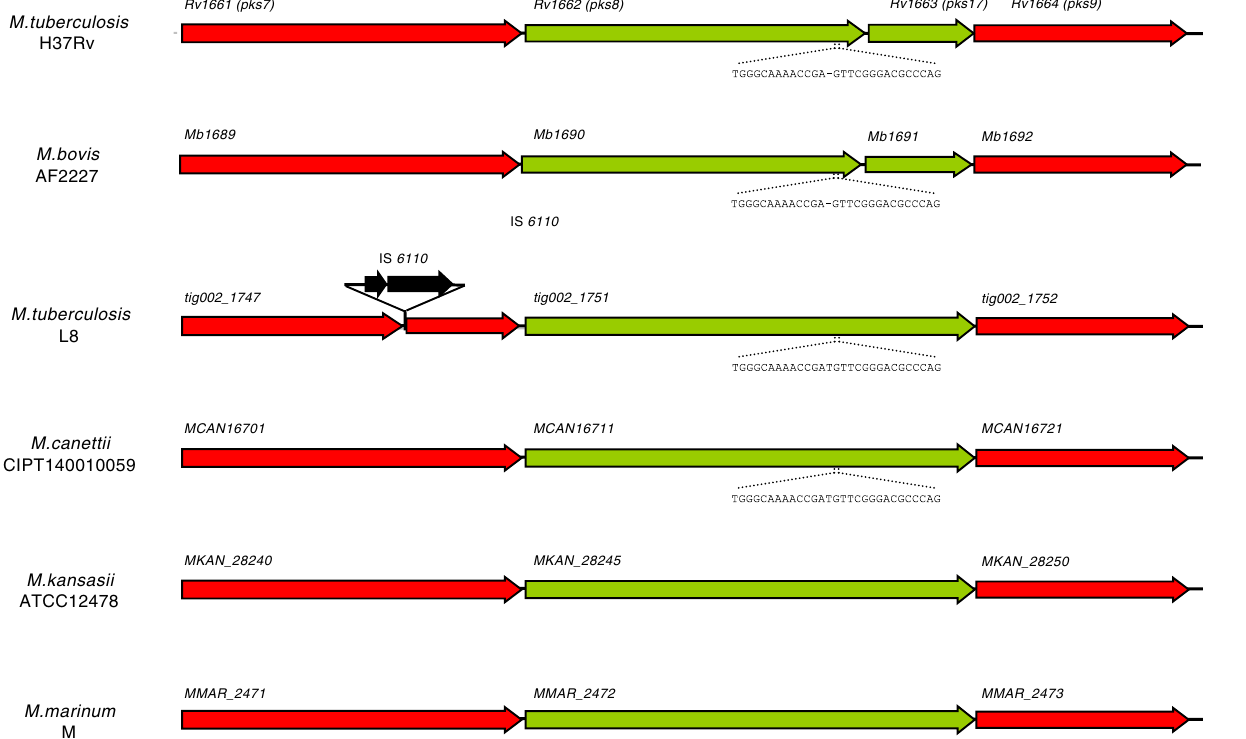
Fig. 5 Architecture of the pks8/17 region of speci fi c Mycobacterium spp. genomes. Aligned genome segments showing the interrupted coding sequences pks8/17 in M. tuberculosis H37Rv and M. bovis AF2122/97, and complete pks8 genes in L8, M. canettii CIPT140010059 (alias STB-A) and M. kansasii ATCC12478. The coding sequences of pks8/17 and pks8 are shown in green, and fl anking genes in red. Sequences fl anking the 1-nucleotide deletion and resulting in a frameshift in M. tuberculosis complex strains are